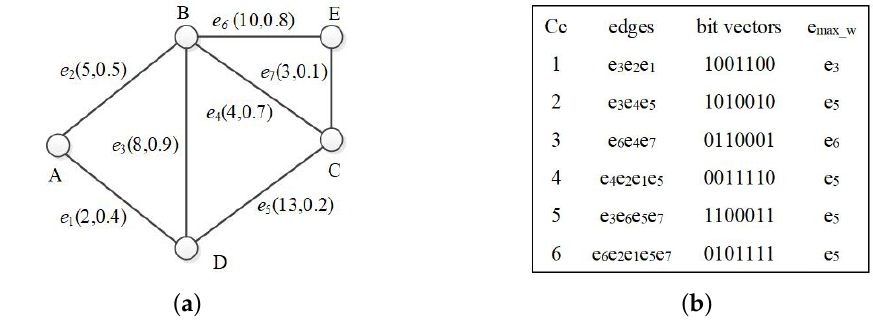
Figure 6. Uncertain graph and cycle information. ( a ) Uncertain graph G 2 ; ( b ) Cycle information of G 2